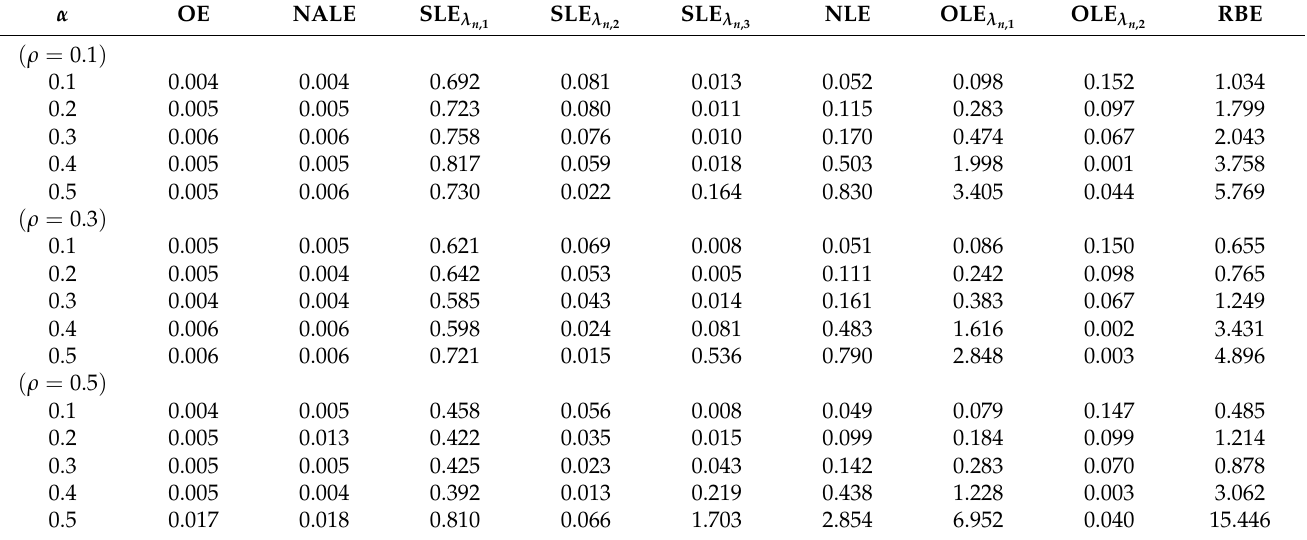
Table 1. Average RE of various estimators, true σ 2 = 0.5.